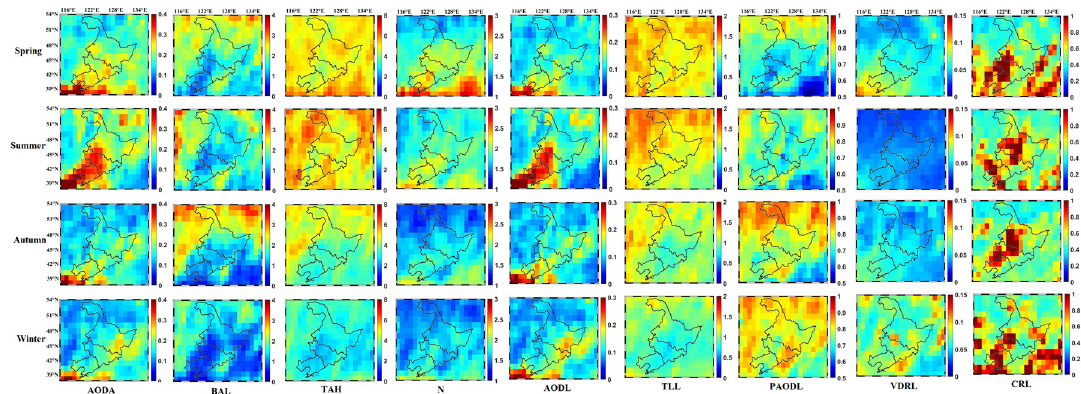
Figure 9. Seasonal spatial distributions of AODA, BAL, TAH, N, AODL, TLL, PAODL, VDRL, and CRL over NEC (HLJ, JL, and LN) in the nighttime.